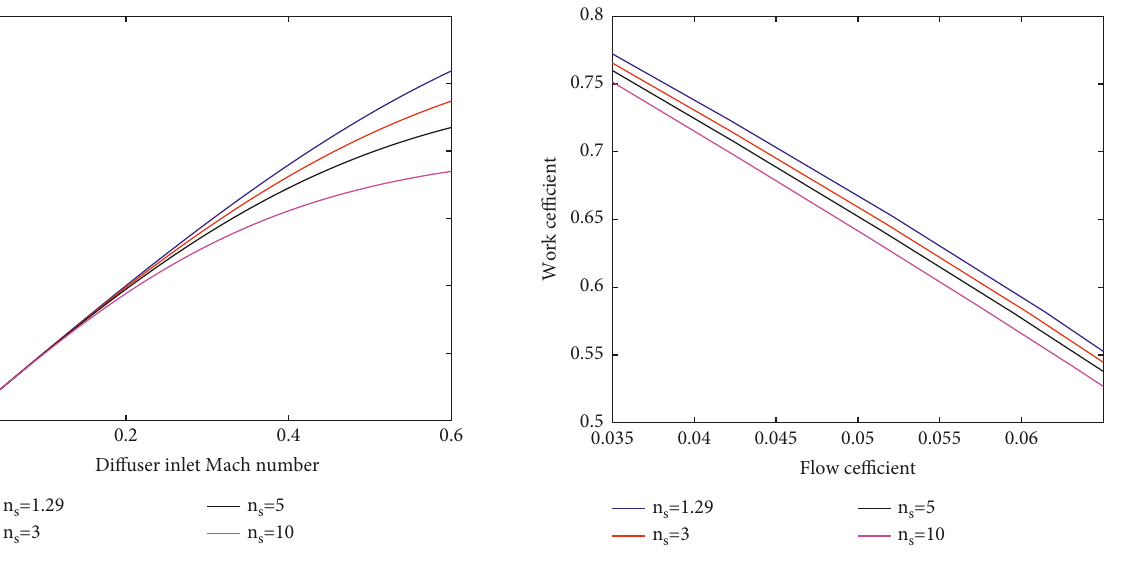
Figure 7: Isentropic exponent effects on the impeller work coefficient.